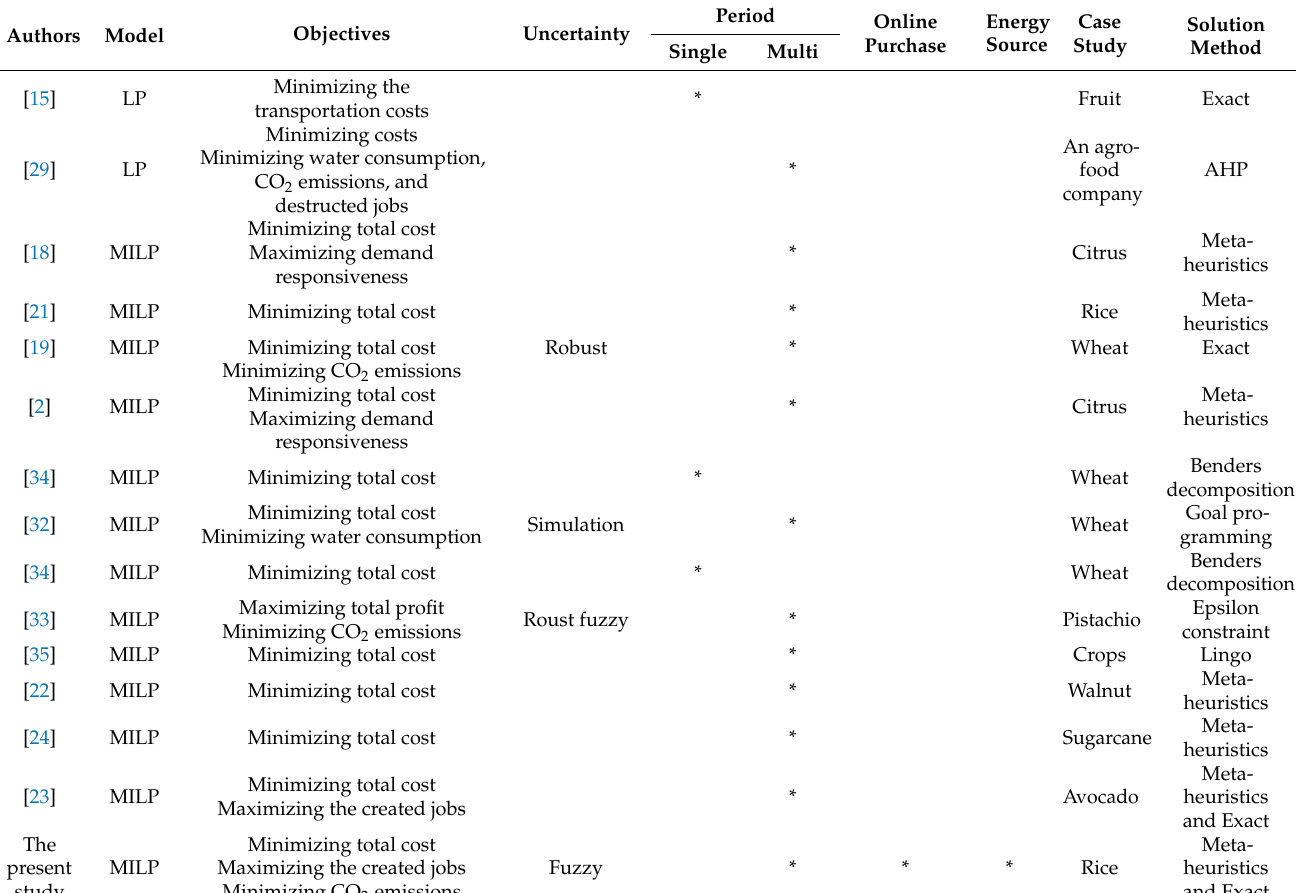
Table 1. Some papers published in the scope of